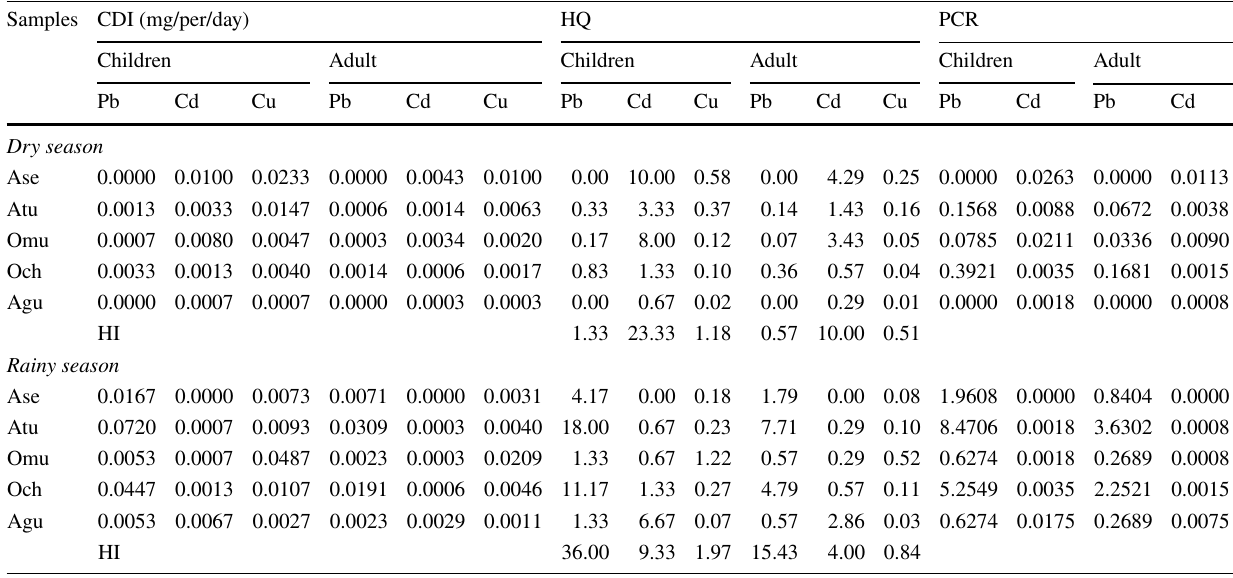
Table 9 Chronic daily intake (CDI), hazard quotient (HQ), hazard index (HI) and probable cancer risk (PCR) for children and adult Samples CDI